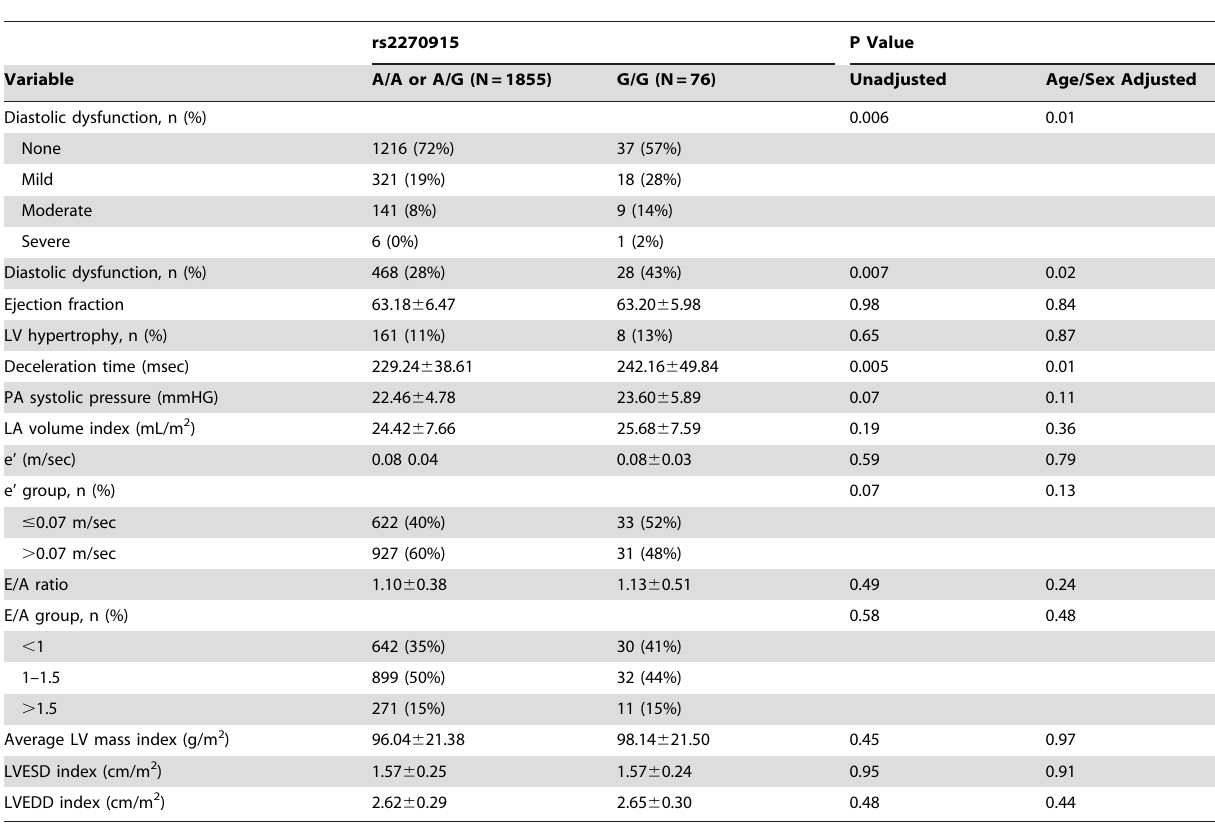
Table 2. Echocardiographic Parameters in the Study Population Across the rs2270915 Genotype.